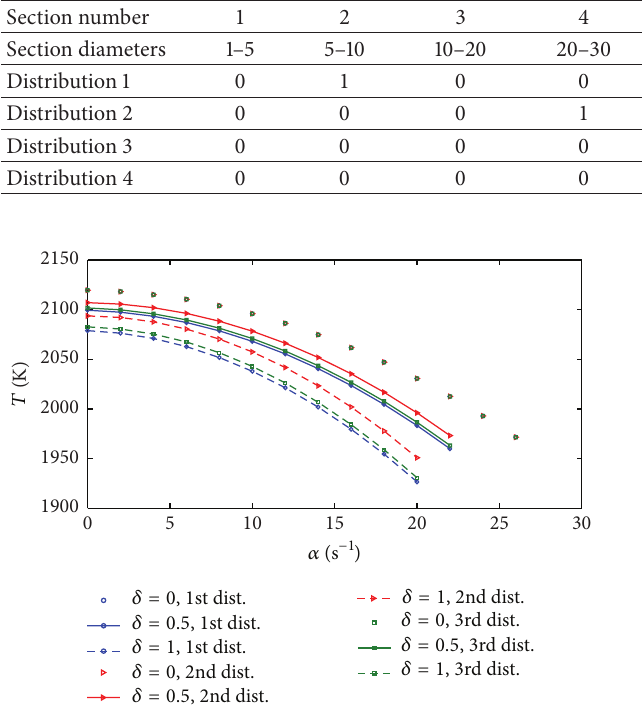
Figure 13: Influence of heat loss parameter on spray flame temper- ature for different initial droplet loads—polydisperse case.